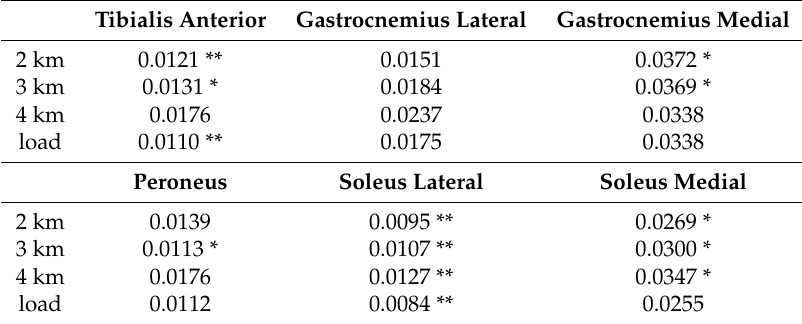
Table 4. Median root mean squared errors [mV] of each task based on the proposed method (* p < 0.05, ** p <